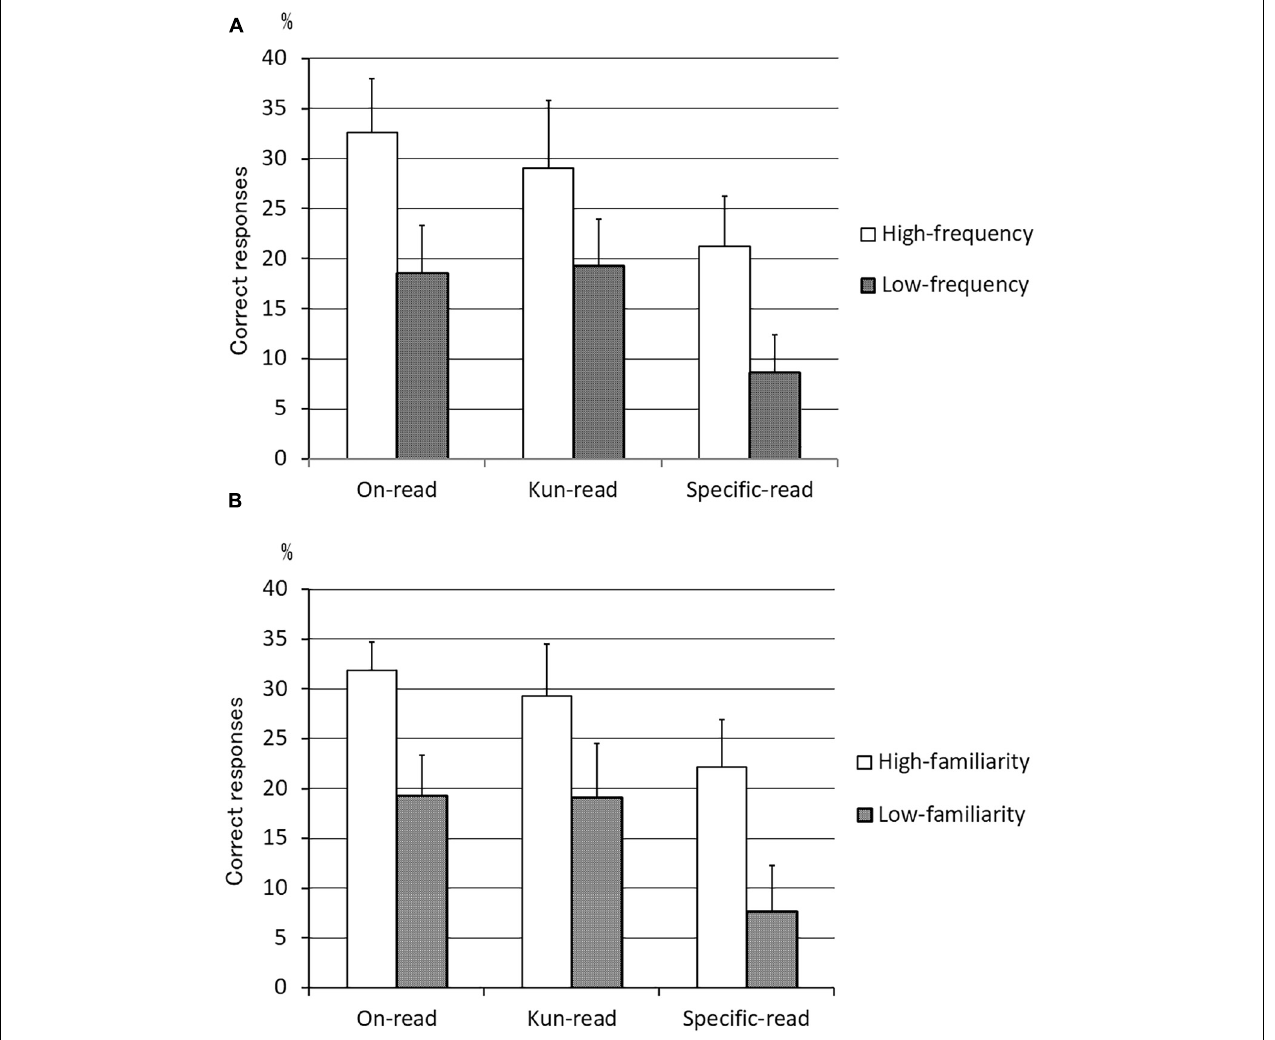
FIGURE 3 | Mean rates of high- and low-frequency words and high- and low-familiarity words with correct responses in the on-kun reading test. (A) Mean % correct high- and low-frequency words. (B) Mean % correct high- and low-familiarity words. High-frequency or high-familiarity words were read more accurately than low-frequency or low-familiarity words in each reading test. On -reading predominance over kun -reading (not significant) and kun -reading predominance over specific-reading were observed only with high-frequency or high-familiarity words ( n = 7). On -reading words = 60 words, Kun -reading words = 60 words, and Specific-reading words = 60 words. Error bar denotes standard